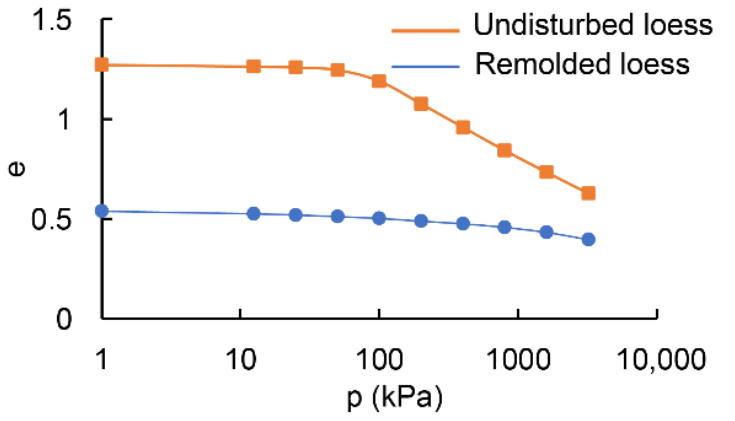
Figure 12. Compression curve shown by e -log p plots (the orange line is undisturbed loess, and the blue line is remolded loess).